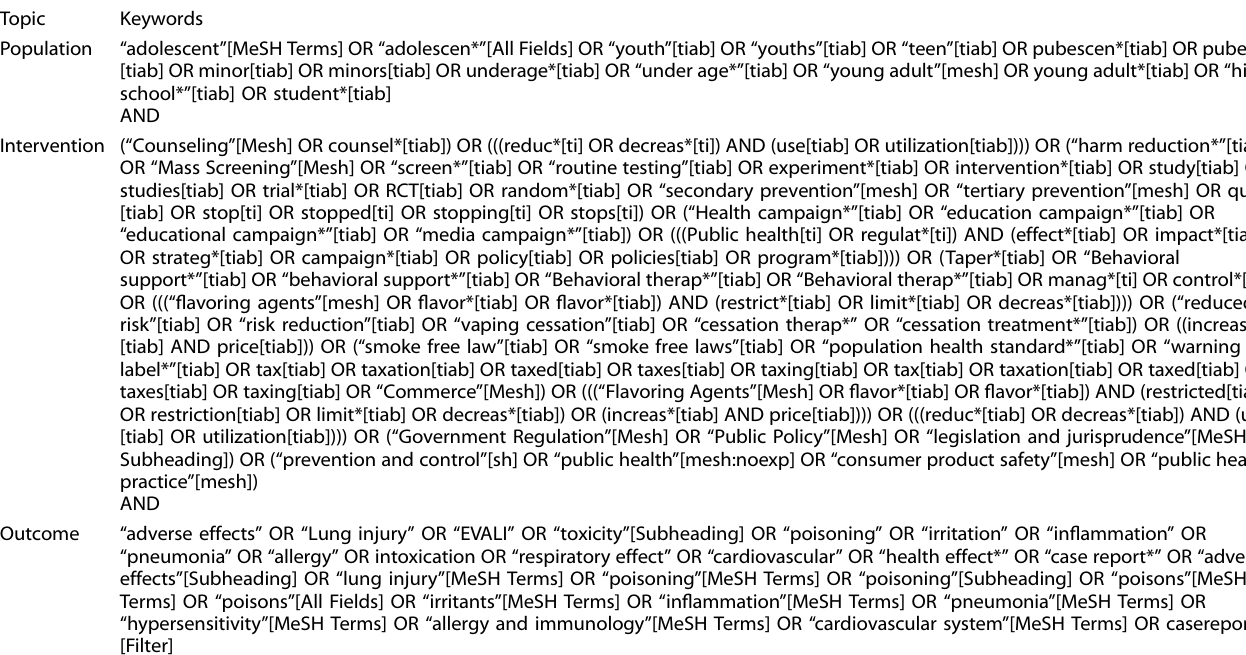
Table 2. PubMed/Medline search